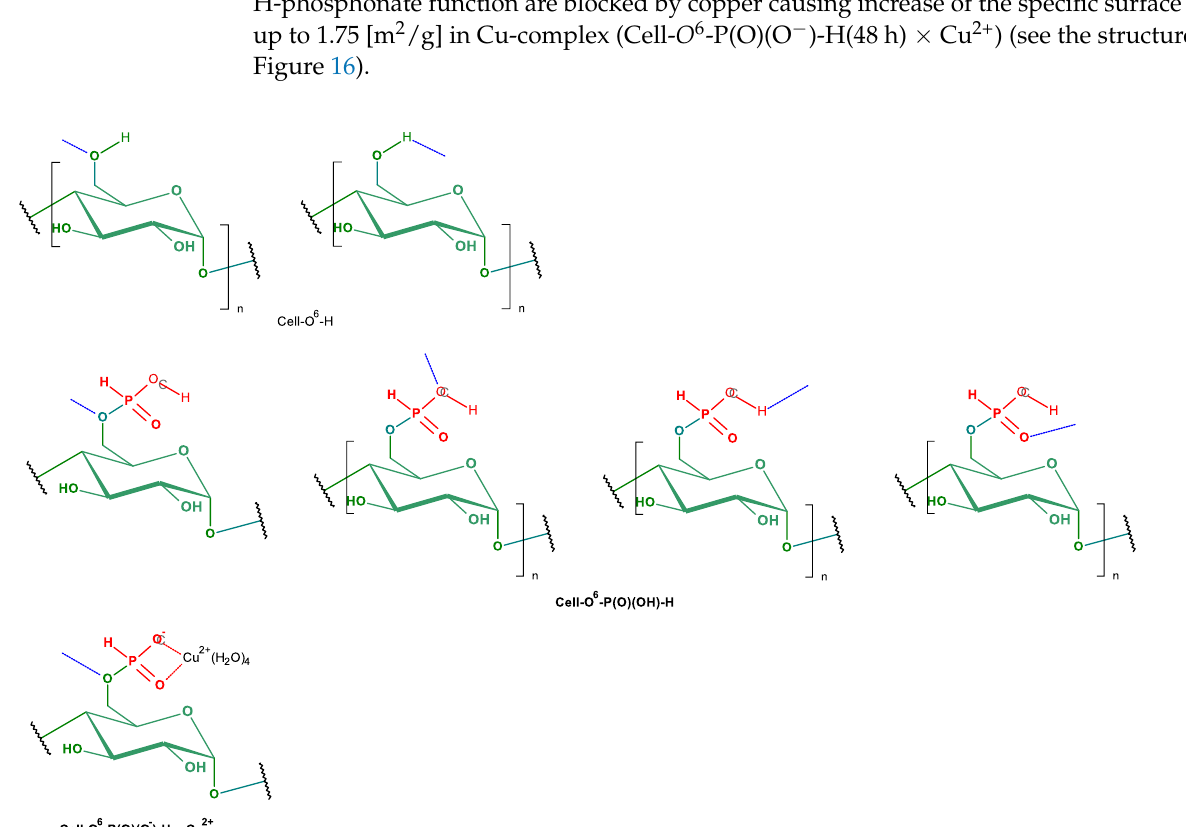
Table 11. Results of tests on the antibacterial activity of Cell- O 6 -P(O)(O - )-H × Cu 2+ complexes, according to standard EN- ISO 20645:2006 [78].